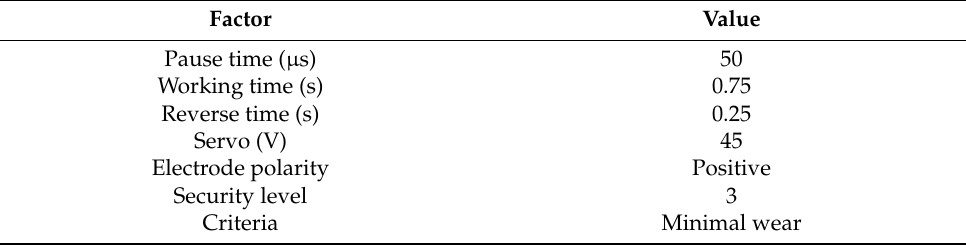
Table 4. Fixed factors and selected values. Table 3. Selected factors and experimental levels.